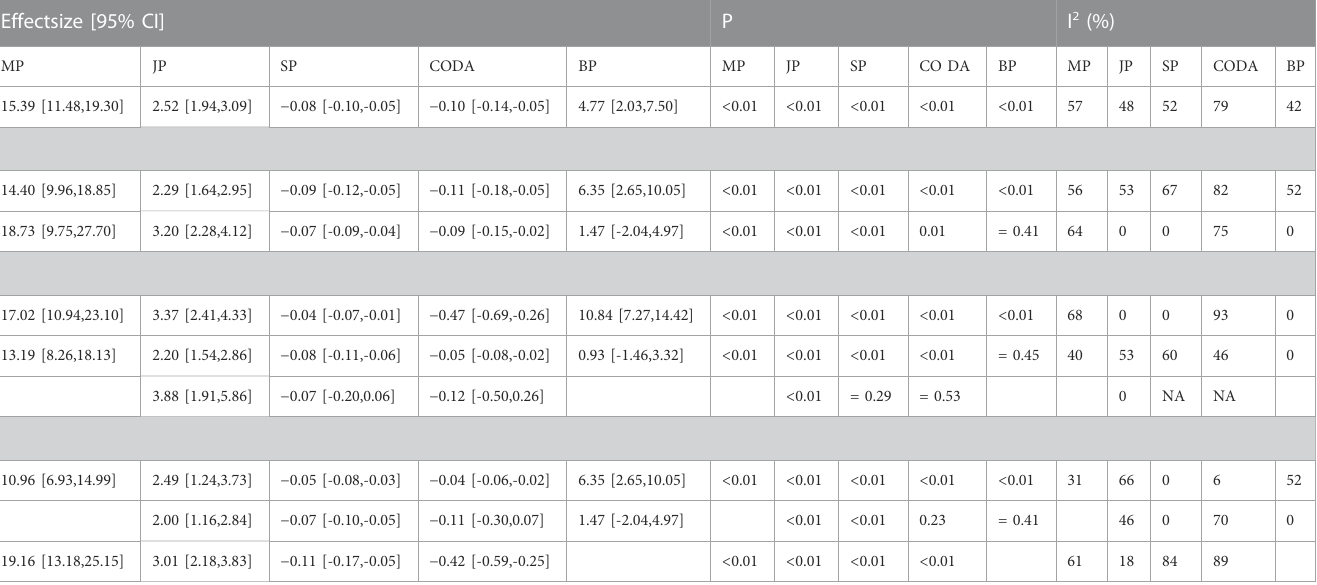
TABLE 4 Study of the effect of UNI training on physical performance.